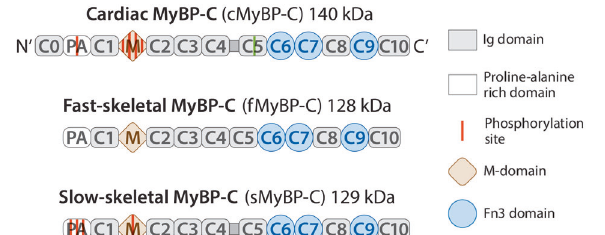
Fig. 2 Domain structure of the 3 isoforms of MyBP-C. The three isoforms of MyBP-C – cardiac, fast-skeletal, and slow-skeletal – all contain seven immunoglobulin domains (Ig), three fi bronectin 3 domains (Fn3), an M-domain, and a proline and alanine-rich region. The linker (horizontal line) between immunoglobulin domains C4 and C5 has been reported in both cardiac and slow-skeletal isoforms of MyBP-C. Top: The cardiac isoform ( MYBPC3 gene) has an additional Ig domain at the N-terminus, 28 residual inserts in the C5 domain (green vertical line), one phosphorylation site in the proline- and alanine-rich region, and four phosphorylation sites in the M-domain. Middle: The fast-skeletal isoform of MyBP-C ( MYBPC2 gene) has no reported phosphorylation sites. Bottom: The slow- skeletal isoform of MyBP-C ( MYBPC1 gene) has three phosphoryla- tion sites in the proline- and alanine-rich region and one site in the